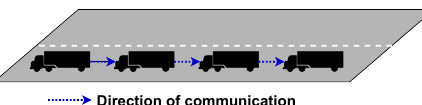
Figure 5. Decentralised topology of platooning